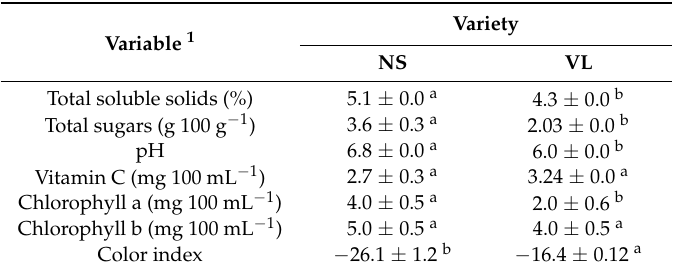
Table 1. Physicochemical characteristics of juices from Sechium edule var. nigrum spinosum (NS) and S. edule var. virens levis (VL).